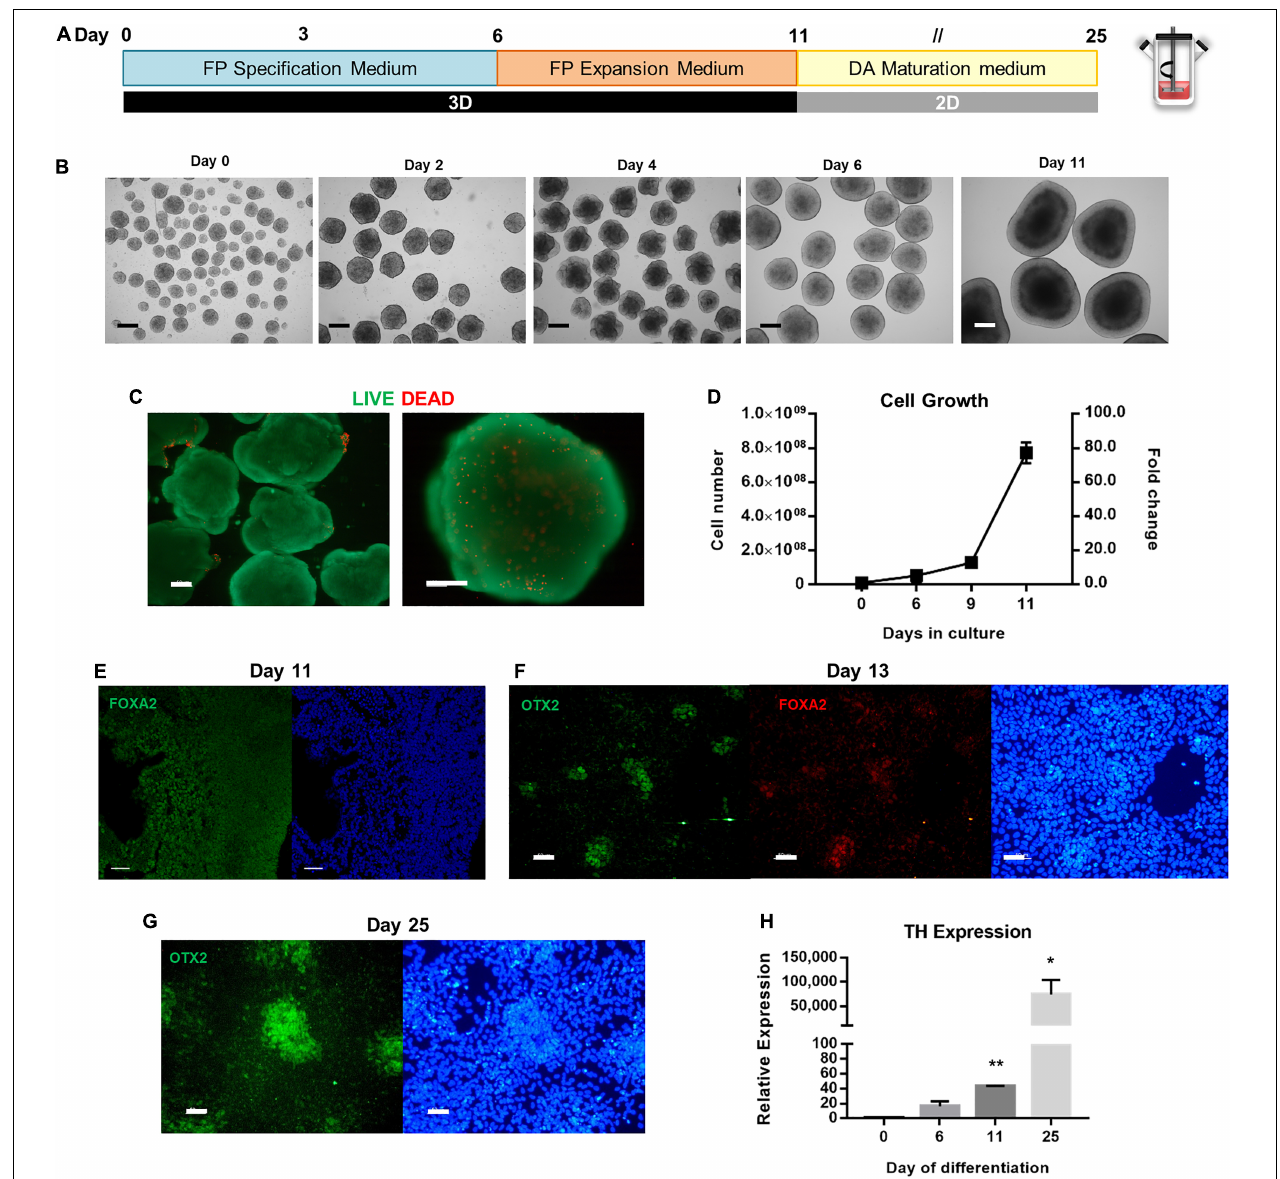
FIGURE 4 | Scalable differentiation of hiPSCs into FP Progenitors using spinner flasks. (A) Schematic overview of FP specification and dopaminergic neuron maturation until day 25 of differentiation. (B) Bright Field images of 3D aggregates between day 0 and day 11. Scale bars: 300 µ m. (C) LIVE/DEAD assay of FP progenitors recovered at day 11. Green: calcein-AM; Red: Ethidium homodimer-1. Scale bars: 100 µ m. (D) Growth curves of hiPSC undergoing FP specification and expansion in spinner flasks through 11 days, for total cell number and cell yield. Representative immunofluorescence images for the FP marker FoxA2 in aggregates recovered at day 11 (E) , on replated cells at day 13 (F) , and Otx2 on replated cells at day 25 (G) . Scale bars: 50 µ m. (H) Quantitative RT-PCR analysis of TH mRNA expression levels (2 − (cid:49)(cid:49) Ct ) relative to GAPDH. * p < 0.05; ** p <